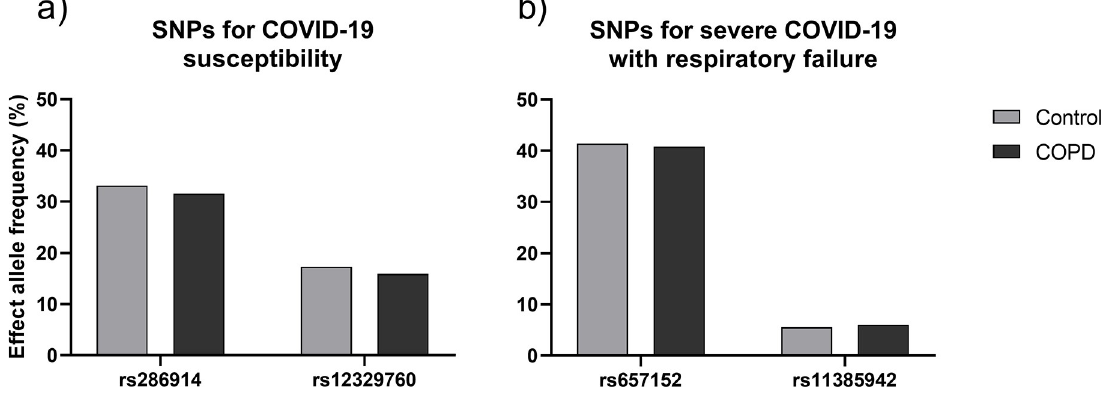
Fig 1. Allele frequencies for significant SNPs, for a) susceptibility (rs286914 and rs12329760) and b) severe response (rs657152 and rs11385942) to COVID-19 infection. No significant differences were found between COPD and control groups for any of the tested SNPs; rs286914: p-value = 0.60; rs12329760: p-value = 0.55; rs657152: p-value = 0.85; rs11385942: p-value =